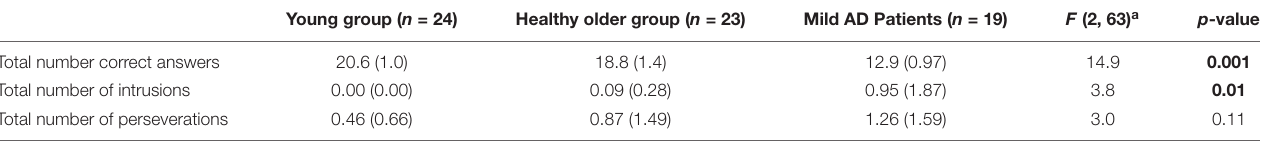
TABLE 2 | Means and SD for standard scores of the “animal” category in the 1-min trial. a